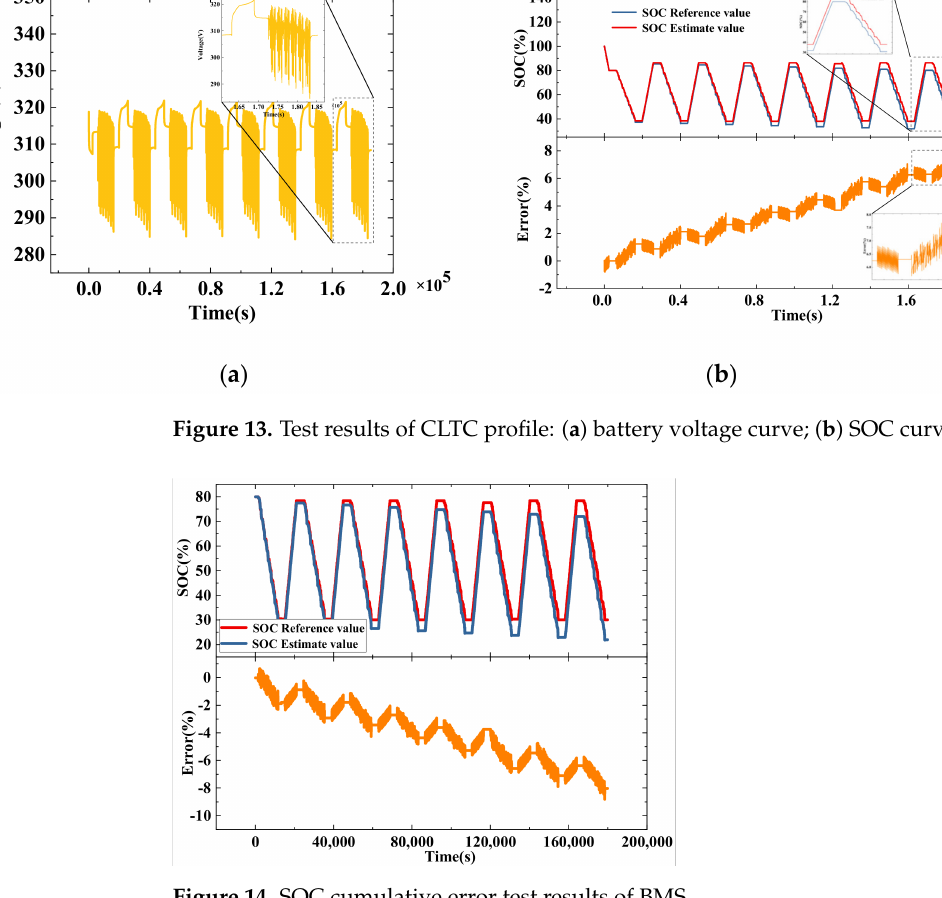
Figure 14. SOC cumulative error test results of